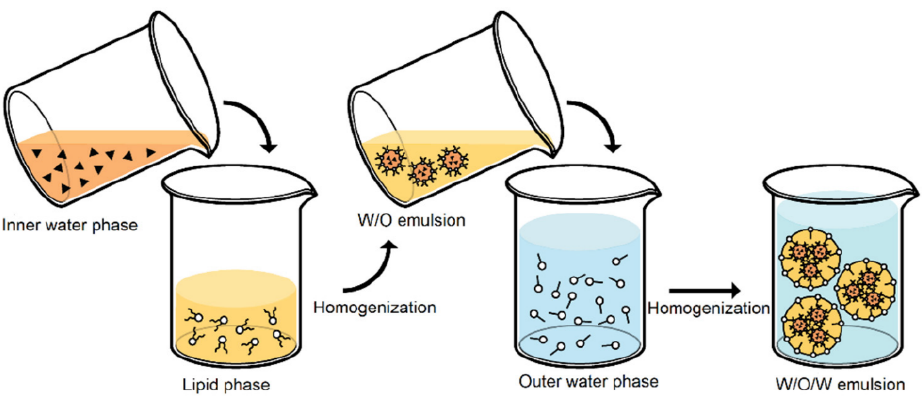
Figure 4. W/O/W double emulsion technique for the preparation of solid lipid nanoparticles. Reprinted from Ref. [35].